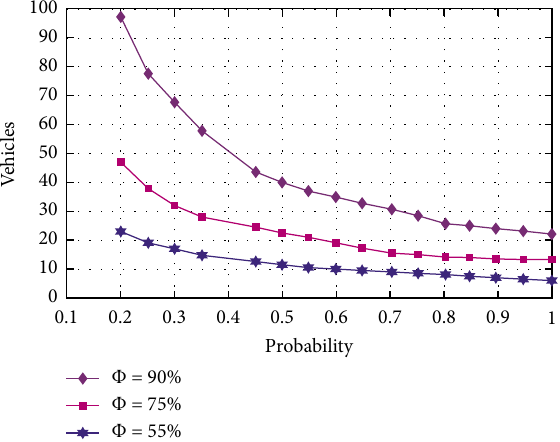
Figure 12: Influence of number of vehicles on the probability of traffic information data.